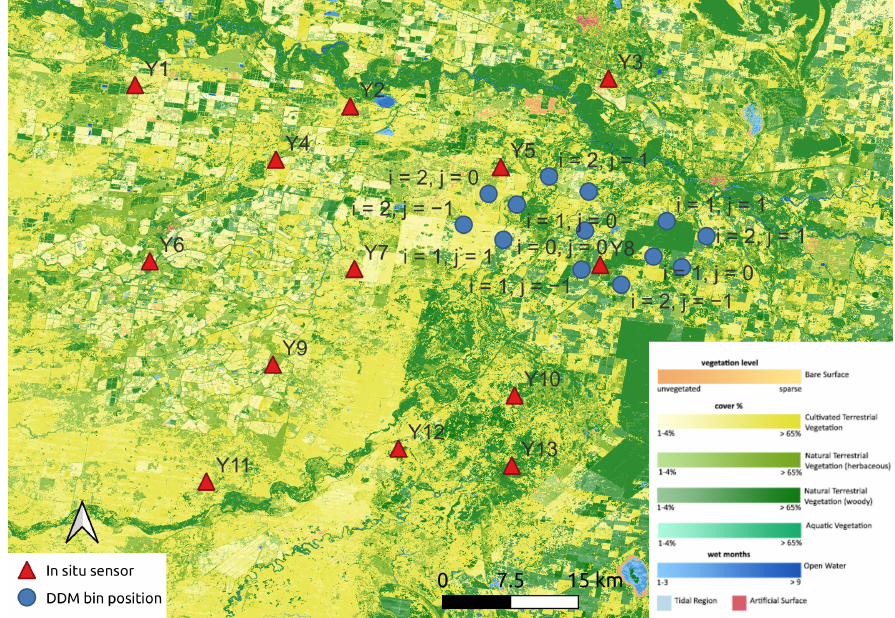
between 17 km and 32 km. The lower limit is the first Fresnel zone, and the upper limit is the maximum distance between two points in the area of the selected 3 × 5 box of the DDM.